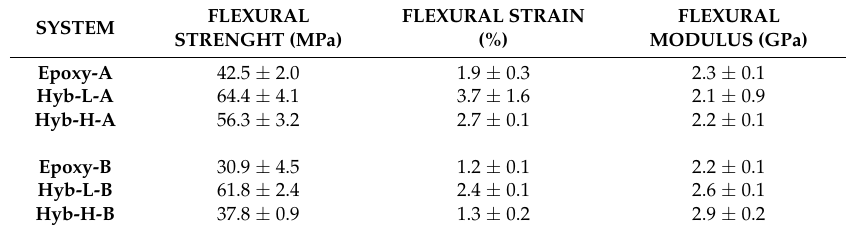
Table 4. Mechanical results for the neat epoxy and the hybrid epoxy–silica resins at different DES contents and curing agent typology.